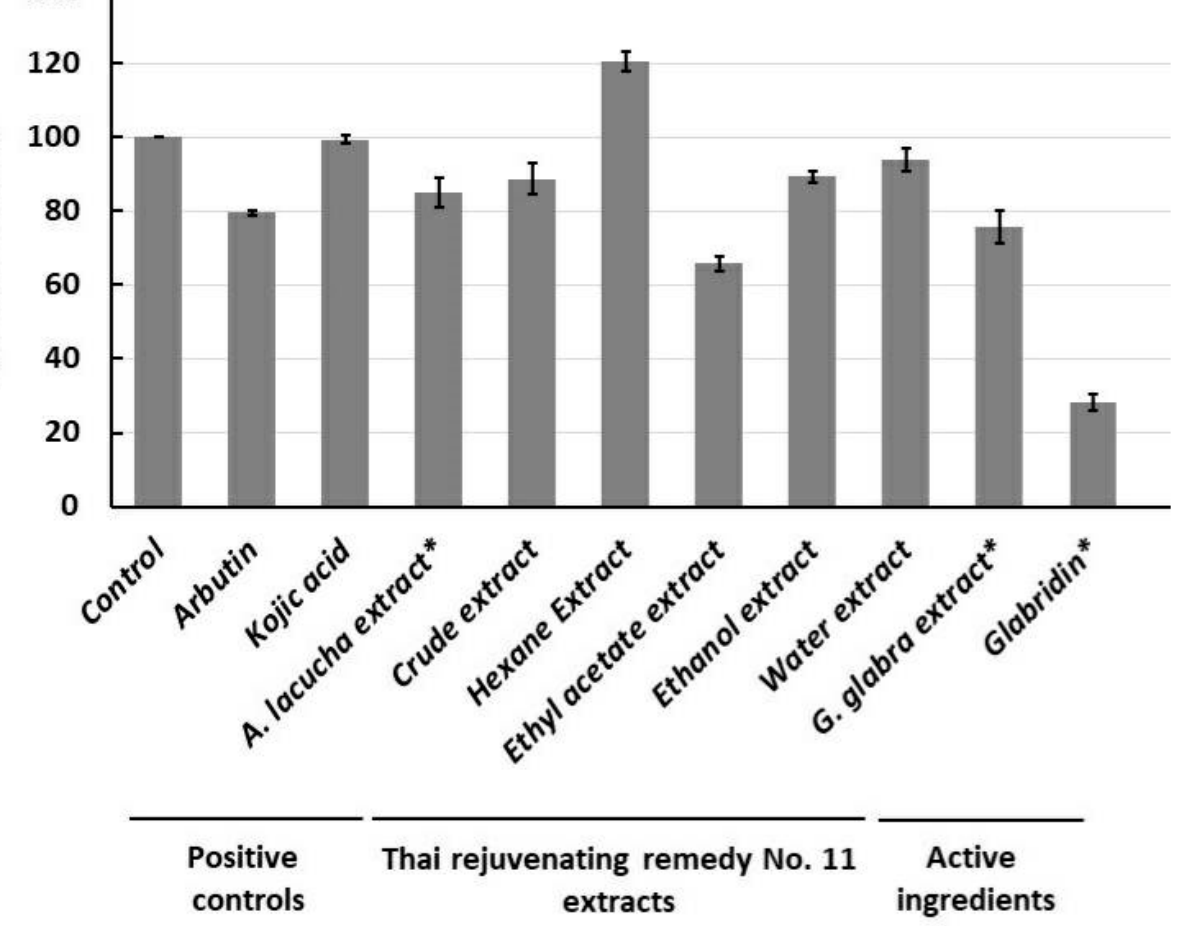
Figure 4. Anti-murine melanoma (B16F1) intracellular tyrosinase activity of positive controls (arbutin, kojic acid, and A. lacucha wood extract), Thai rejuvenating remedy No. 11 extracts (crude, hexane, ethyl acetate, ethanol, and water extracts), and active ingredients ( G. glabra extract and glabridin) at concentrations of either 5 or 25 µg/mL. * Indicates samples tested with a concentration of 5 µg/mL. All samples are tested in triplicate (N = 3).